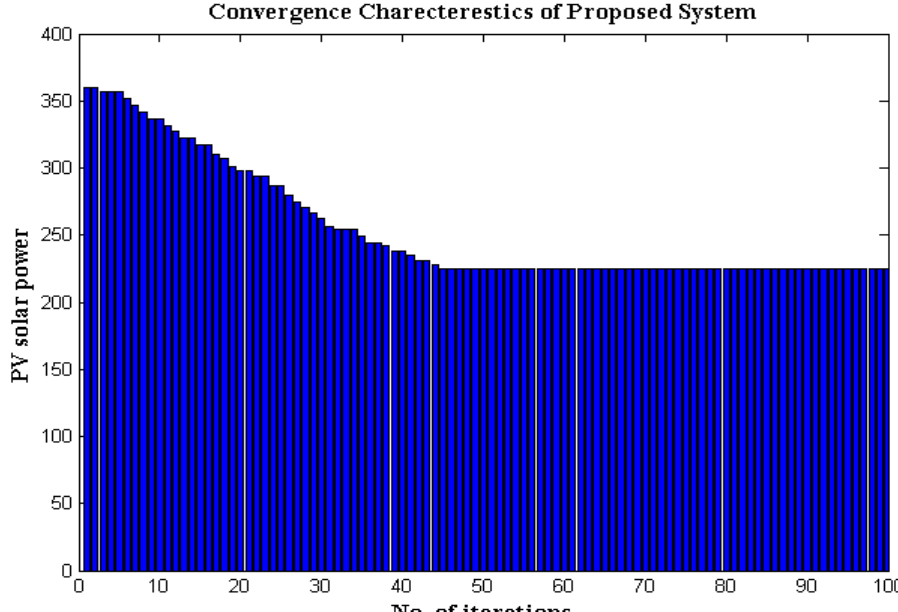
Figure 14. Convergence characteristics.